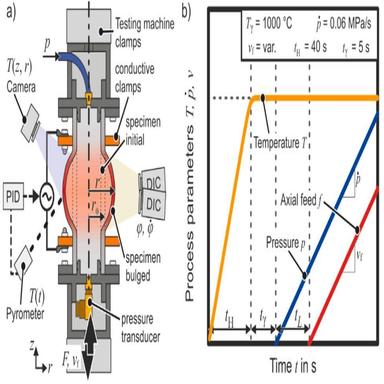
a) Experimental set-up for the hot-tube-bulge test and b) aspired profiles of the process variables temperature T, pressure p and axial feed f over time.